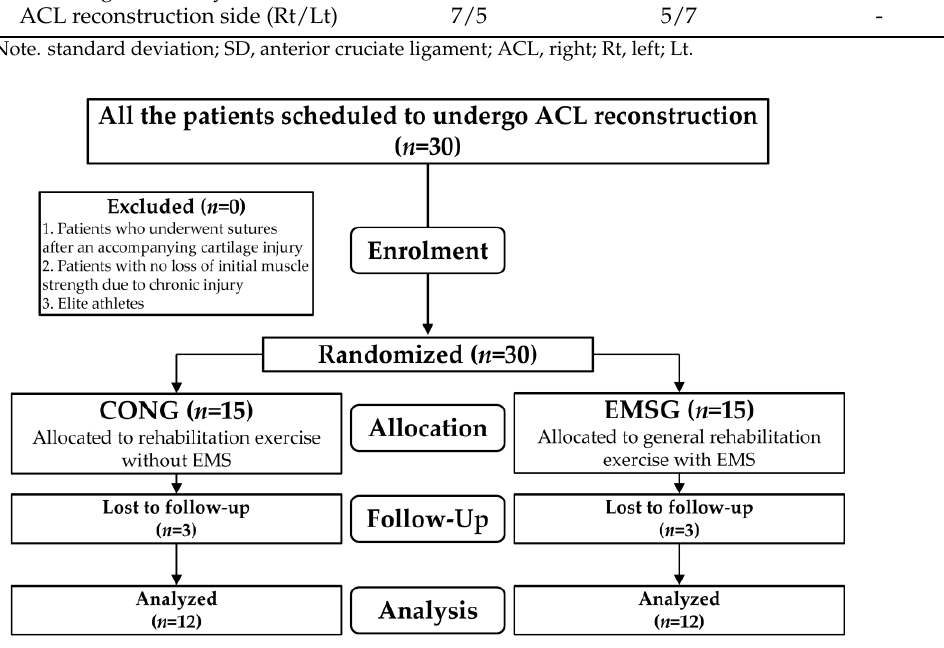
Figure 1. The CONSORT Flow Diagram. control group; CONG, electro muscle stimulation group; EMSG.